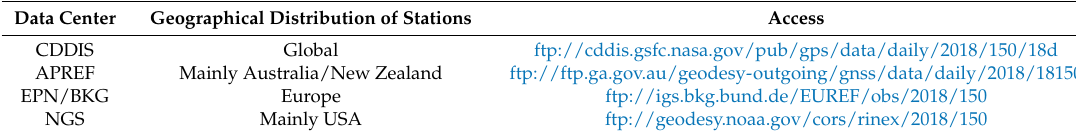
Table 2. GPS observation data sets, RINEX-2, DoY 150,